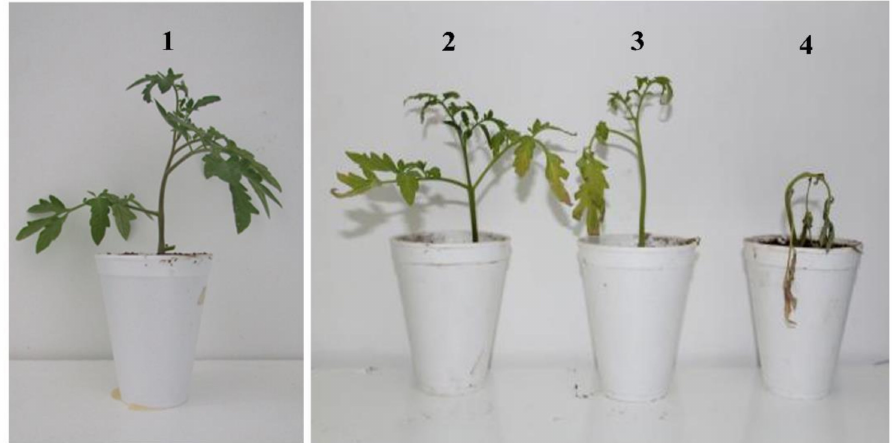
Figure 1. Representation of damage produced by Fusarium oxysporum fsp . radicis-lycopersici (FORL). This procedure was used to generate an ad hoc severity index.